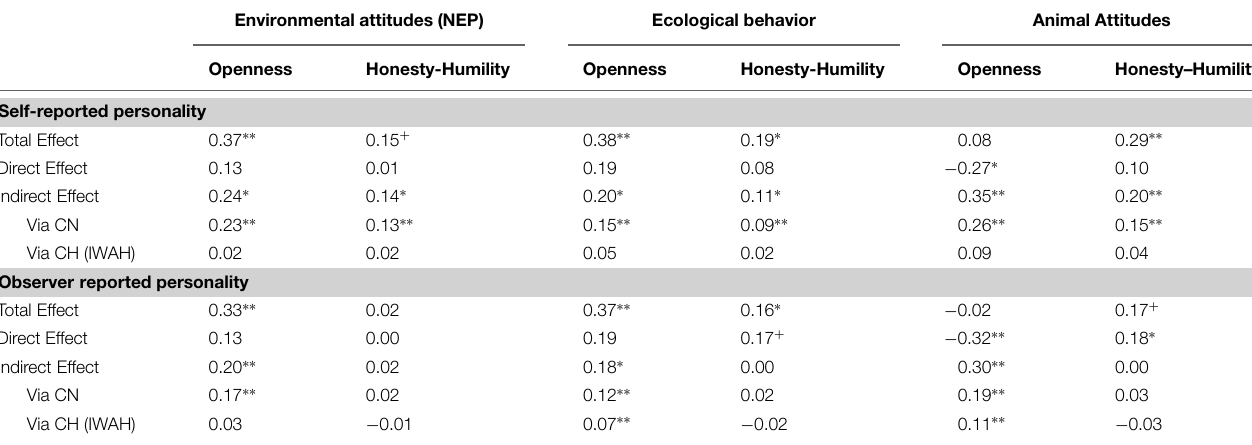
TABLE 2 | Results of the mediation